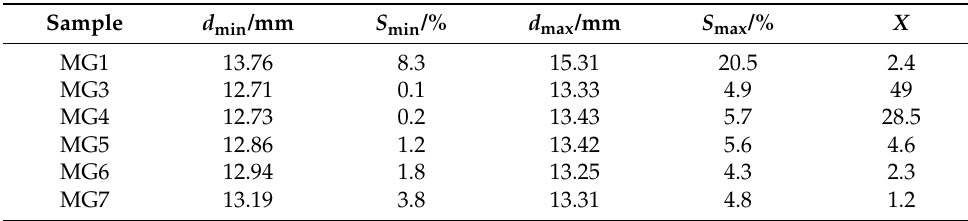
Table 1. Experimental values of d min , S min , d max , S max , and X.